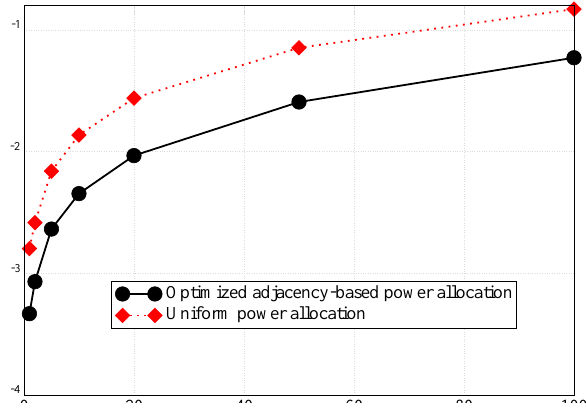
Figure 15. P comparison between the proposed power allocation scheme and the uniform er transmit power allocation